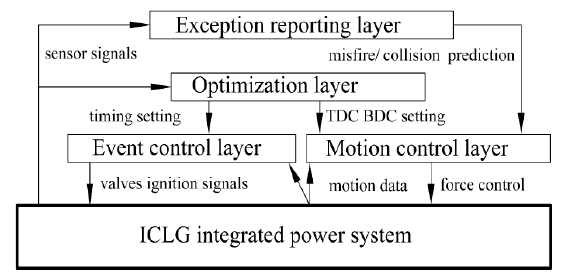
Figure 27. Hierarchical hybrid control strategy of FPLG [7].